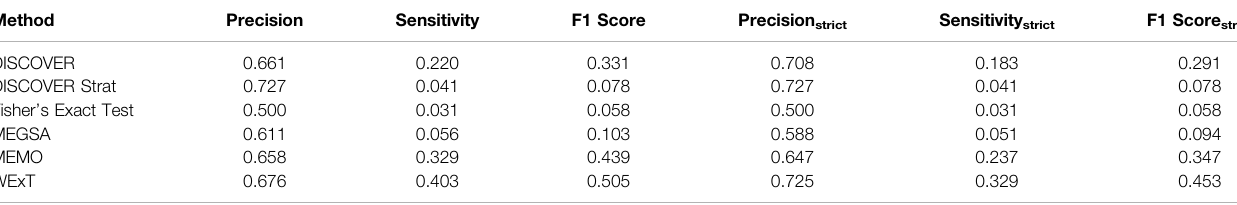
TABLE 1 | Results of network-centric ME evaluation framework with control group X 1 COADREAD t20 (498 samples, 196 CGC-CGC pairs).